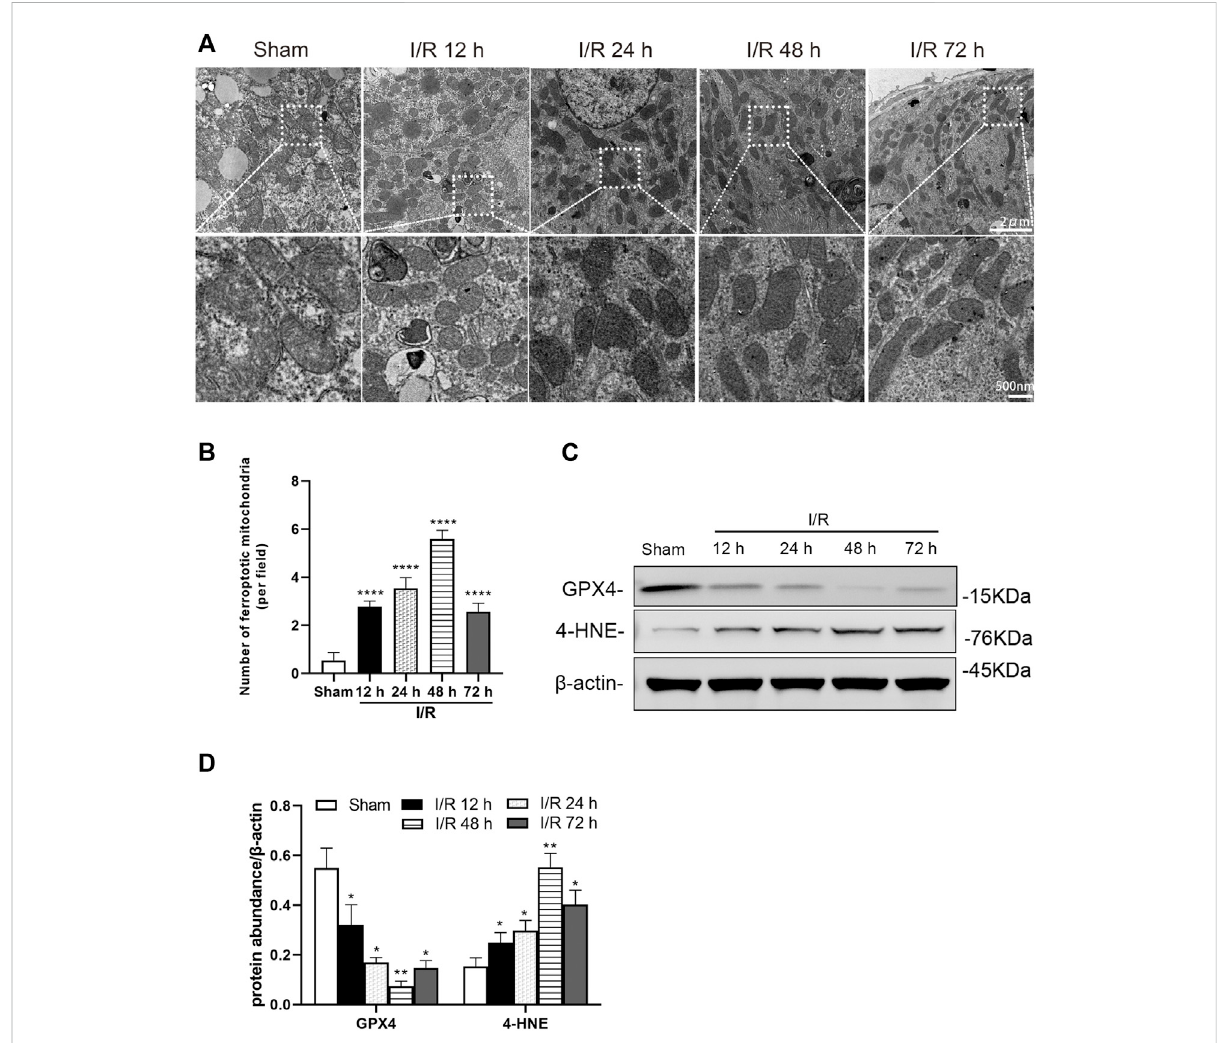
FIGURE 2 Detection of ferroptosis in the renal tubules of mice at 12, 24, 48, and 72 h after I/R (A) Transmission electron microscopy was used to observe the mitochondria of renal tubules (B) The numbers of ferroptotic mitochondria per fi eld in different groups were compared (C) Western blotting detection of GXP4 and 4-HNE in the renal tissue (D) Protein synthesis of GXP4 and 4-HNE in western blotting. Due to the death of mice, N = 5 for eachgroup.Statisticalsigni fi canceisdenotedas*: p < 0.05,**: p < 0.01,****: p <